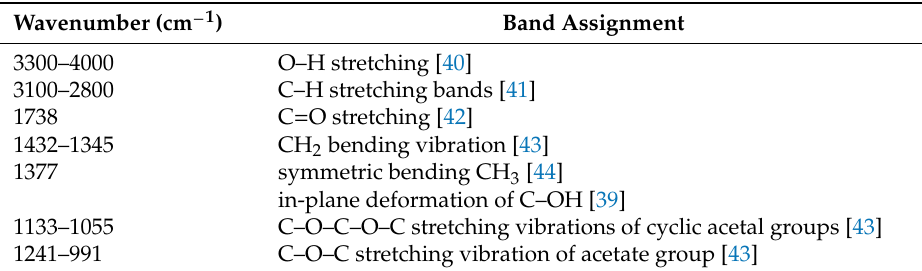
Table 1. Band assignment of FTIR absorption bands from